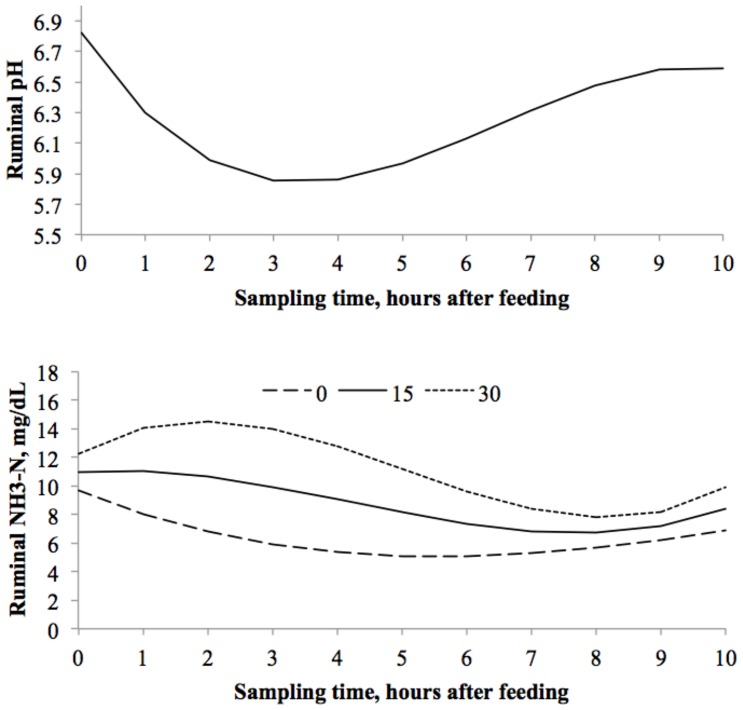
Effect of glycerin inclusion on ruminal pH and NH3-N over time in dual-flow continuous culture system.pH = 6.825 ± 0.1727 - (TIME x 0.6487 ± 0.07149) + (TIME2 x 0.1281± 0.01751)—(TIME3 x 0.00656 ± 0.001143); R2 = 0.999, MSE = 0.139. NH3-N = 9.6399 ± 1.4148 + (glycerin x 0.08728 ± 0.05779) + (glycerin x TIME x 0.146 ± 0.06041)—(TIME x 1.8245 ± 1.1698)—(glycerin x TIME2 x 0.03459 ± 0.0148) + (TIME2 x 0.2095 ± 0.2866) + (glycerin x TIME3 x 0.002012 ± 0.000966)—(TIME3 x 0.00546 ± 0.01871); R2 = 0.381, MSE = 11.75.